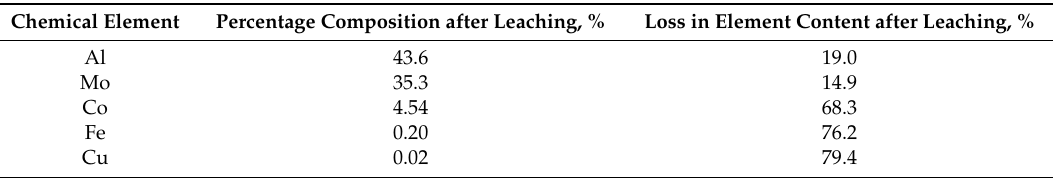
Table 1. An exemplary composition of the spent catalyst after leaching with 1 M H 2 SO 4 at 55 ◦ C, S / L = 1 / 20 g / cm 3 .